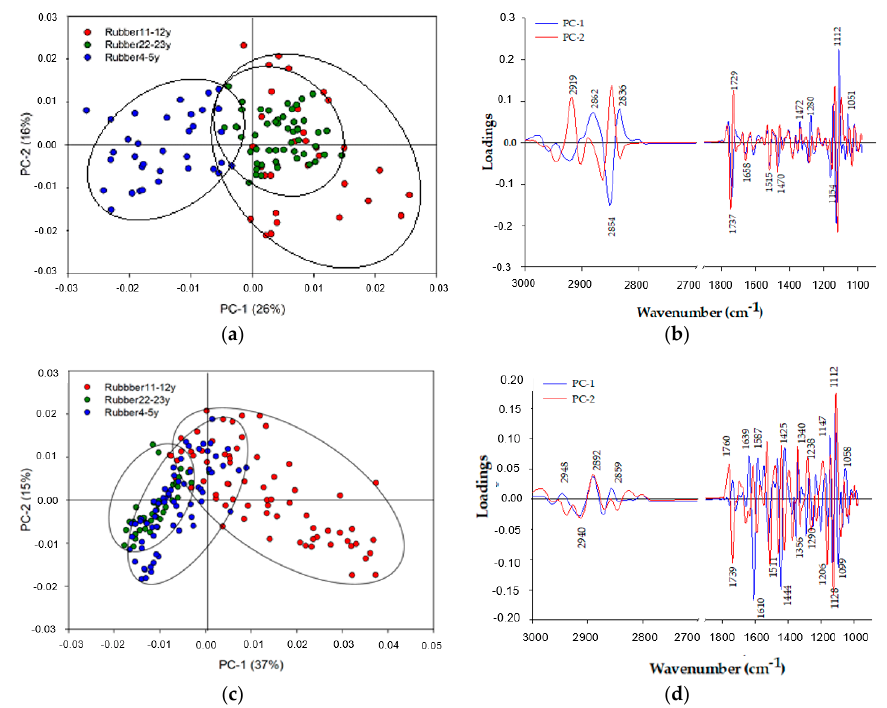
Figure 3. Principal component analysis (PCA) analyses of rubber tree leaves: ( a , b ) Score and loading plots derived from the PCA analyses of epidermis groups; ( c , d ) score and loading plots derived from the PCA analyses of the mesophyll.